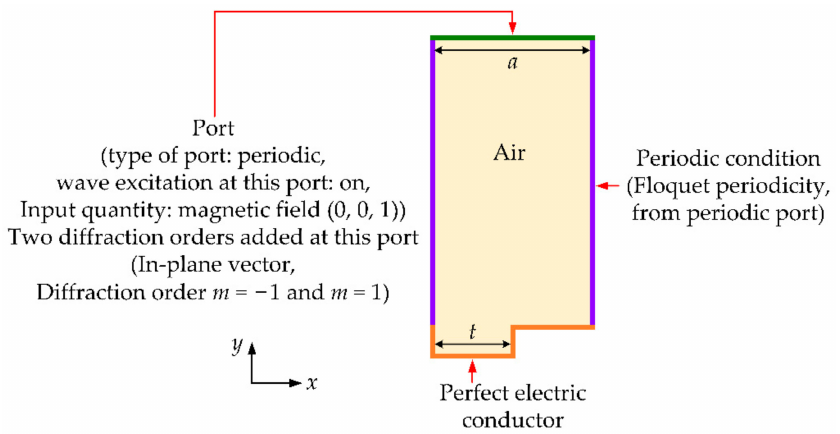
Figure 3. The numerical model to calculate the reflection of the diffracted waves of n = 0, n = − 1, and n = 1 as a function of the ratio t / a performed using the COMSOL Multiphysics electromagnetic waves